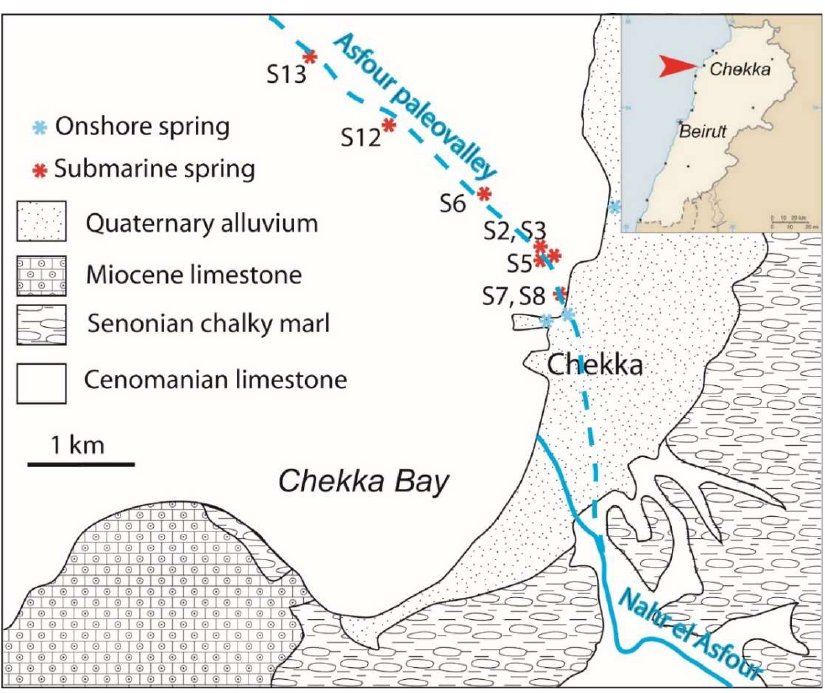
Figure 2. Hydrogeological settings of the Chekka submarine springs. Karst submarine springs (KSMS) (red stars) S6, S12 and S13 are seasonal; S2, S3, S5, S7 and S8 are permanent; other small onshore springs (blue stars) generally discharge brackish water.